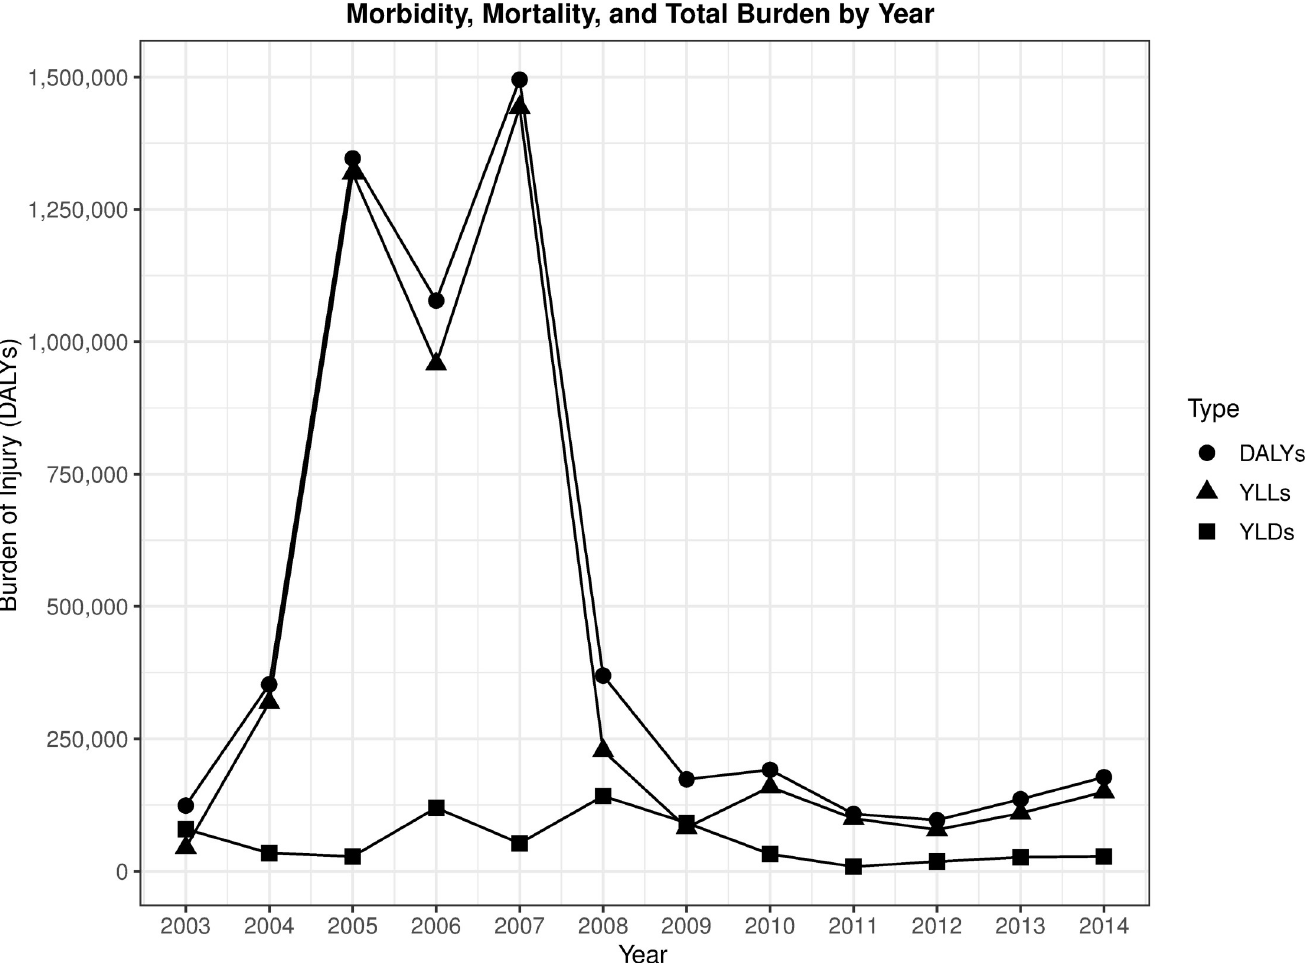
Fig 1. Burden of conflict-related intentional injury by year in Baghdad, Iraq, 2003–2014, portraying total DALYs, as well as contributions of YLLs and YLDs. Source of data: survey of 900 Baghdad residents in May and June 2014, regarding household injury events between 2003 and 2014. DALY, disability-adjusted life year; YLD, year lived with disability; YLL, year of life